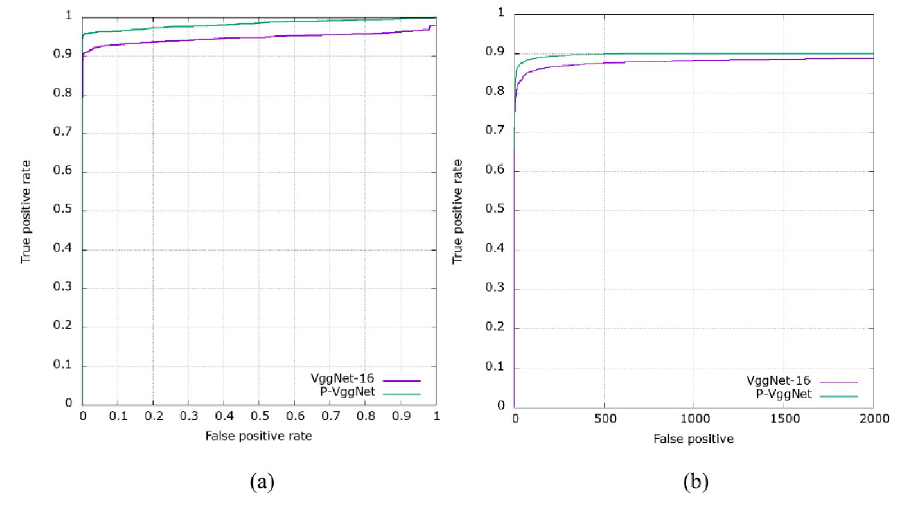
Fig 9. Results on the LWF dataset and FDDB